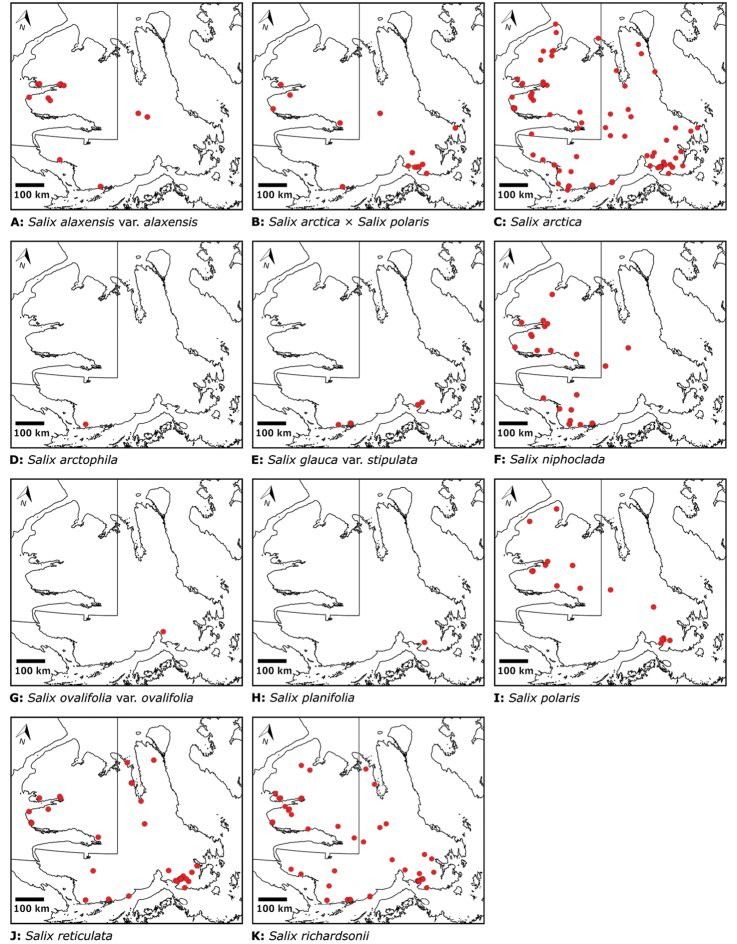
Species distribution maps. Salicaceae: ASalix
alaxensis
var.
alaxensisBSalix
arctica × Salix
polarisCSalix
arcticaDSalix
arctophilaESalix
glauca
var.
stipulataFSalix
niphocladaGSalix
ovalifolia
var.
ovalifoliaHSalix
planifoliaISalix
polarisJSalix
reticulataKSalix
richardsonii.